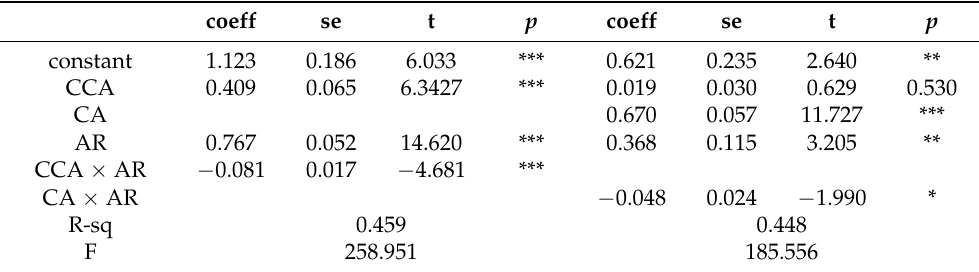
Table 9. Test of moderating effect with CA as mediating